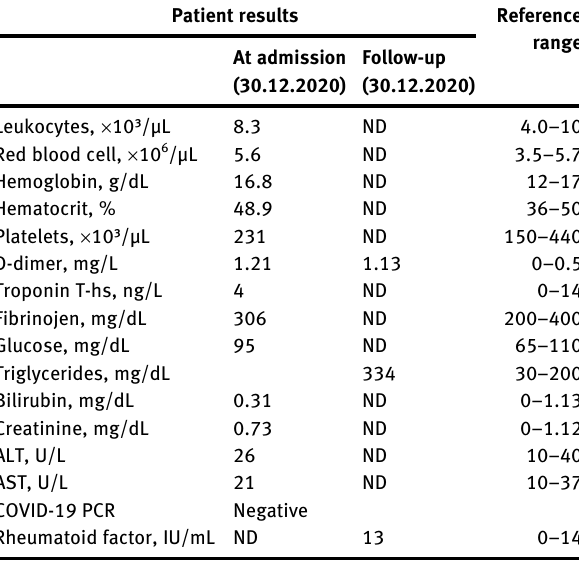
Table  : Laboratory test results.